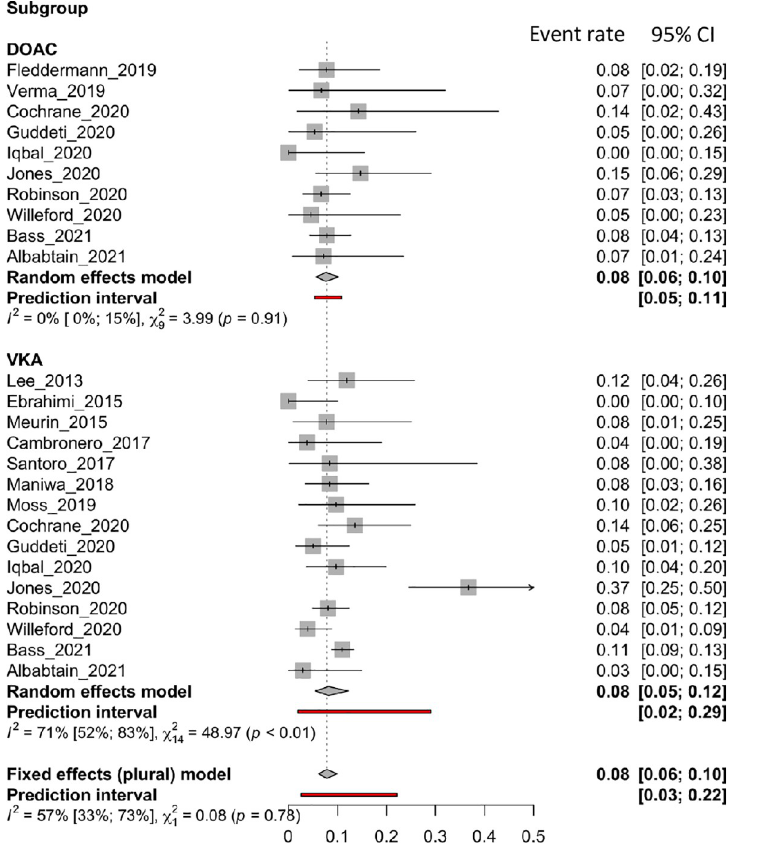
Fig 6. Forest plot of the proportion of any bleeding rate for VKA and DOAC